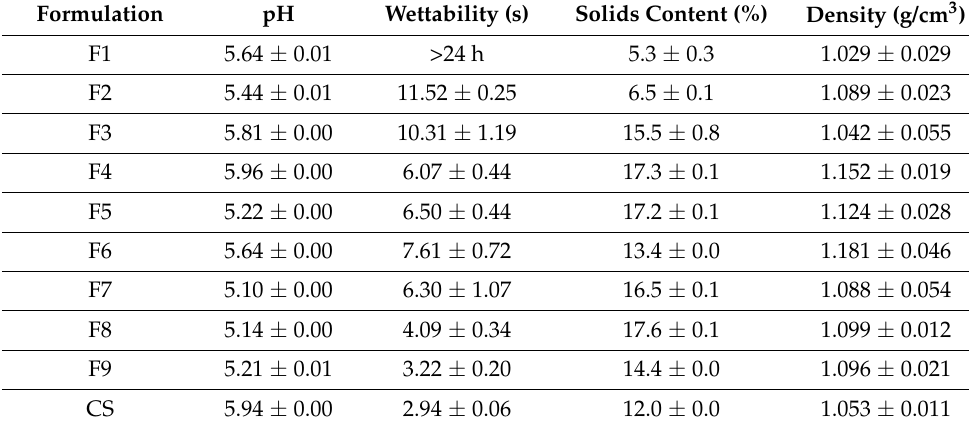
Table 8. pH, wettability, percentage of solids content, and density of formulations. The codes of the formulations are given in Table